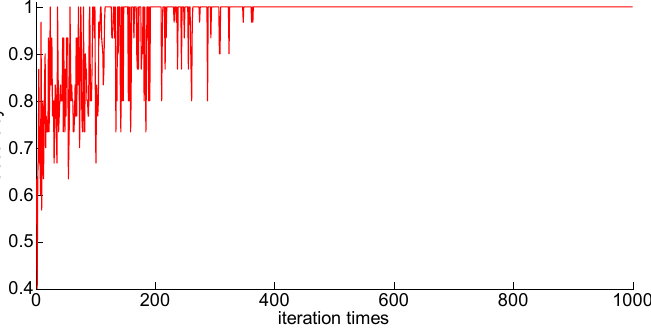
Figure 14. One hundred fifty training samples of the neural network. Table 8. Training outcome indicators for different training sample sizes.